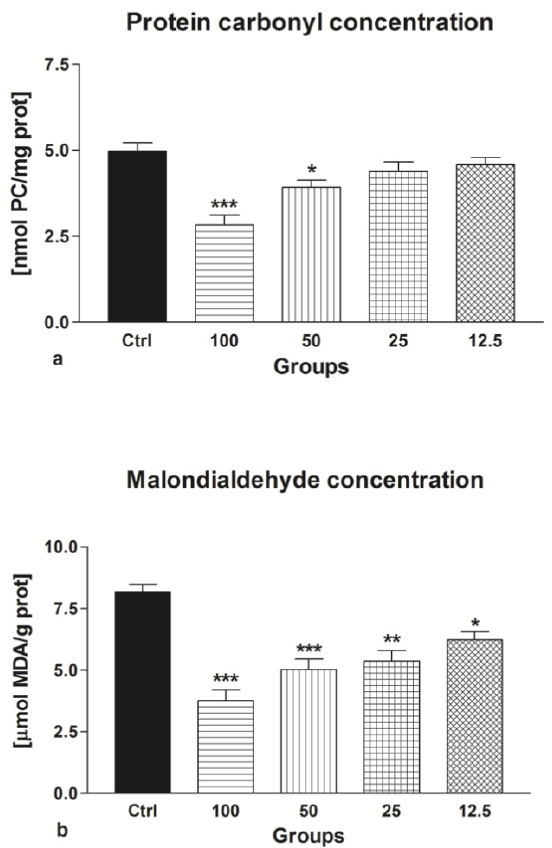
Figure 10. The effect of epicatechin (EPI; μ mol/L) on the sperm protein oxidation ( a ) and lipid peroxidation ( b ) of frozen-thawed bovine spermatozoa. * p < 0.05; ** p < 0.01; *** p < 0.001.